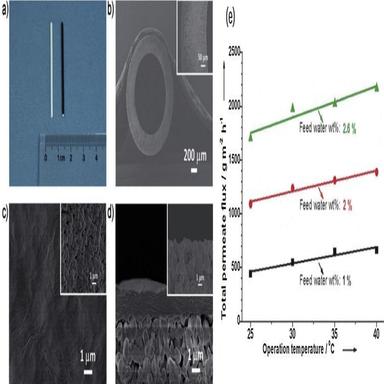
a) Photographs of the blank hollow fiber (white) and the GO membrane (black); SEM images of b) a ceramic hollow fiber (insert: an enlarged cross-section of the ceramic hollow fiber); c) surface and d) cross-section of the blank hollow fiber (inset) and the GO membrane (e) total permeation flux in the DMC/water mixtures.